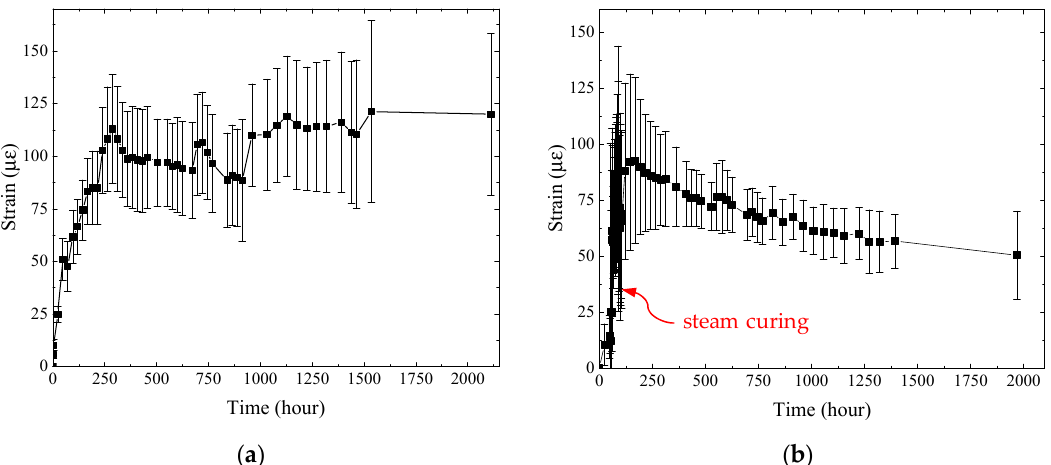
Figure 7. Shrinkage test results: ( a ) shrinkage strain of natural curing part A; ( b ) shrinkage strain of steam curing part C.